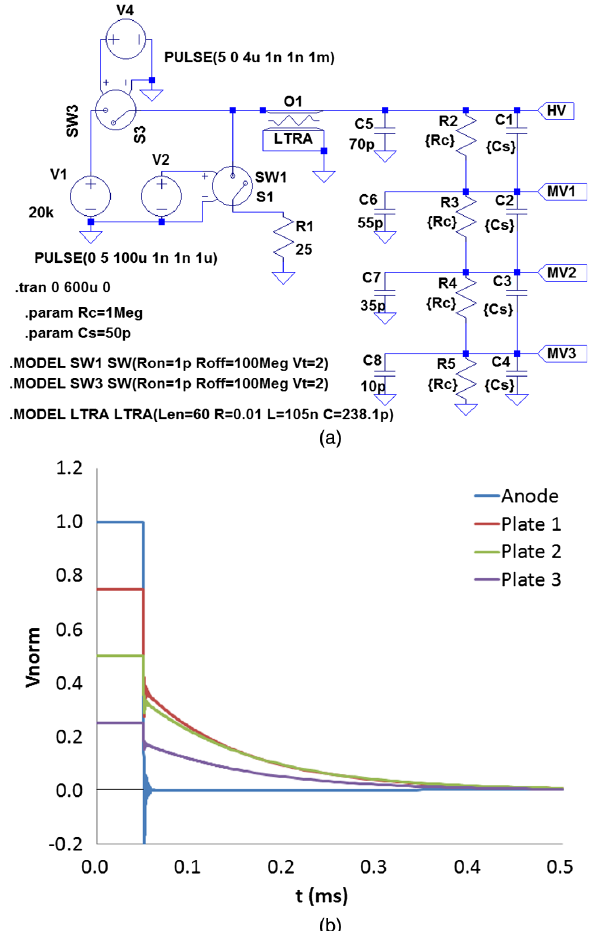
FIG. 14. (a) Modified equivalent circuit of the ES-Kicker system. (b) Simulation result of the voltage pulse around falling edge after optimization of capacitances C9–C12. Here, the voltage is normalized by the anode voltage at the